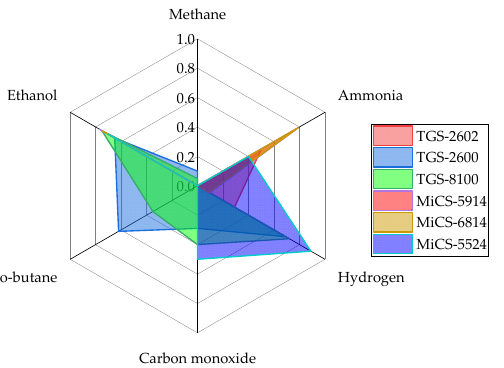
Figure 5. Radar plot of the sensitivity coefficients looked up from the sensors’ datasheets.